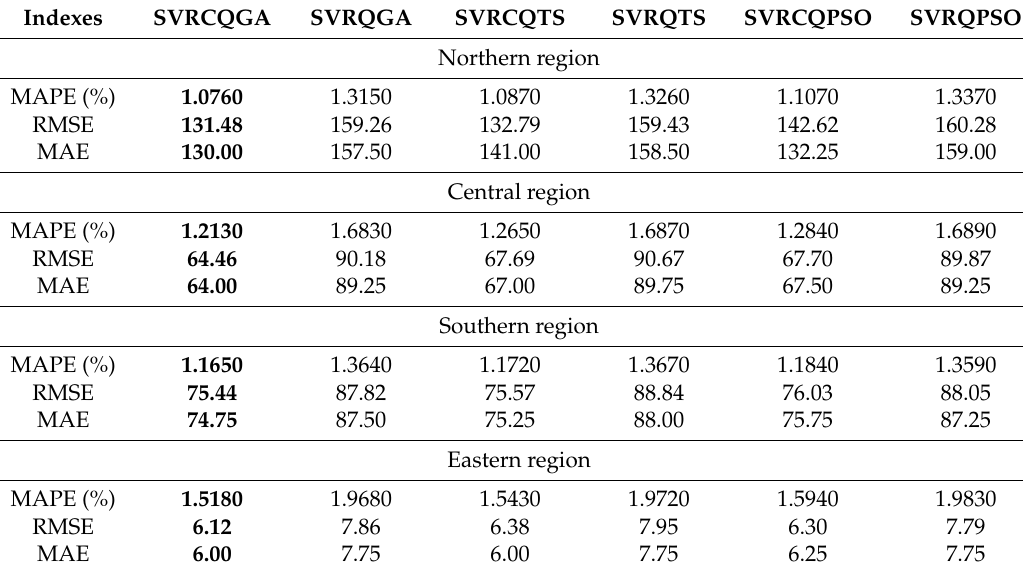
Table 3. Forecasting indexes of SVRCQGA, SVRQGA, and other models (Example